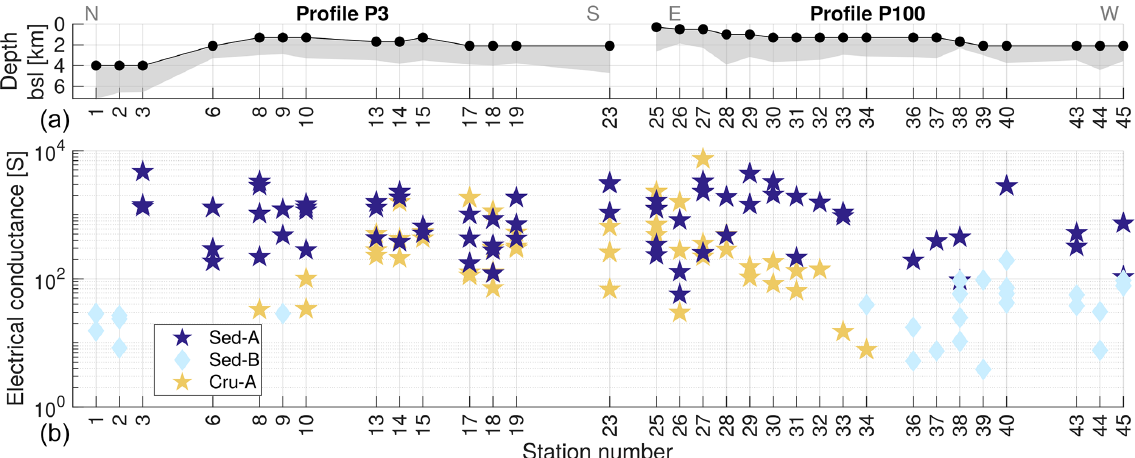
Figure 6. Depiction of the electrical conductance of three shallow clusters. Top panel shows depth of marine MT stations along profiles P3 (stations 1 to 23) and P100 (stations 25 to 45). Grey area shows thickness of seismically derived sediment thickness (Planert et al., 2017, for profile P3, and Fromm et al., 2017a, for profile P100). Bottom panel shows the electrical conductance (conductivity–thickness product) of columns below the corresponding MT station for sediment domain clusters sed-A and sed-B, as well as the crustal cluster